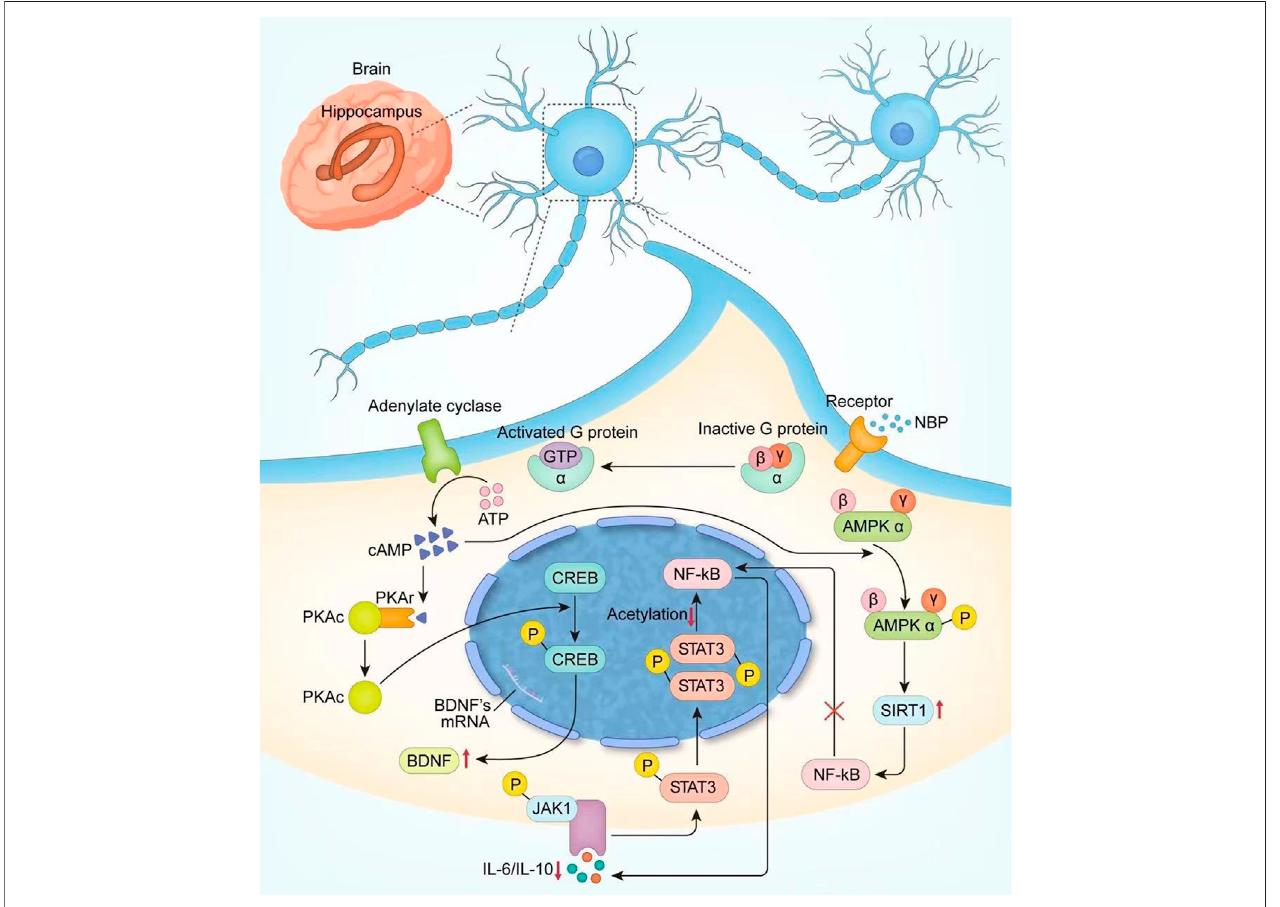
FIGURE 13 | The potential mechanism of